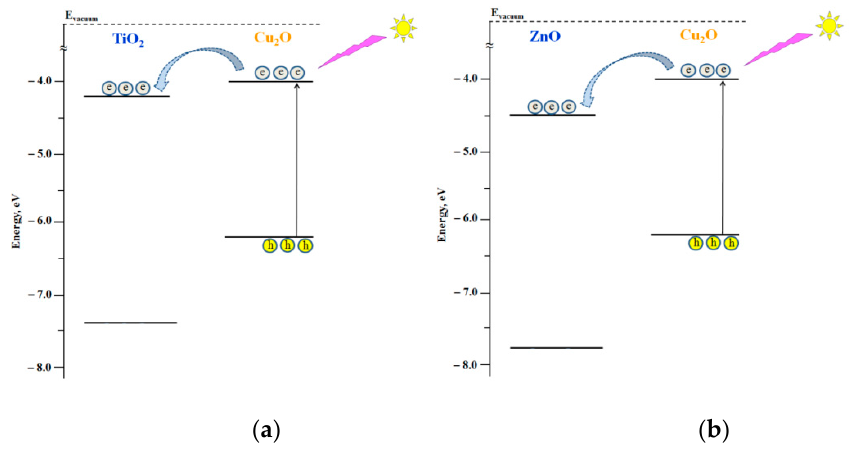
Figure 6. Schemes of the electron transfer in heterostructured coatings under visible light photoexcitation: ( a ) Cu 2 O/TiO 2 and ( b ) Cu 2 O/ZnO.